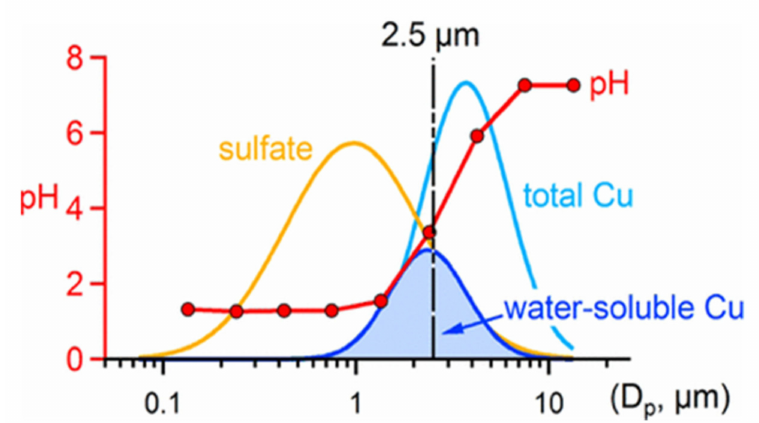
Figure 6. Enhanced metal solubilization induced by acidic sulfates